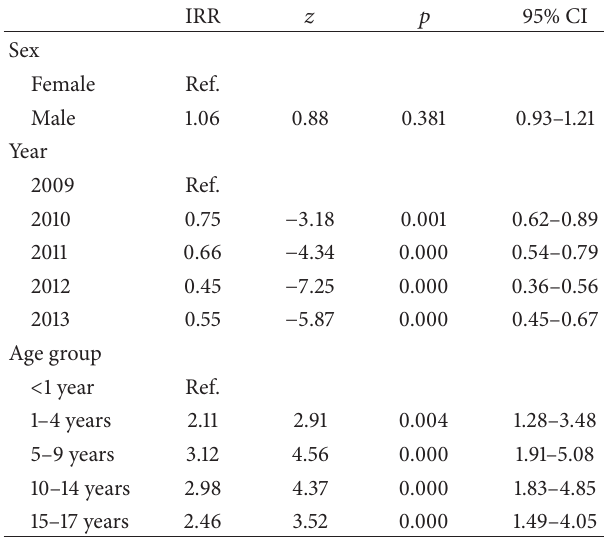
Table 2: Incidence Rate Ratio (IRR) with 95% CI of T1DM among subjects < 18 years, by sex, year, and group of age. Apulia, Italy,